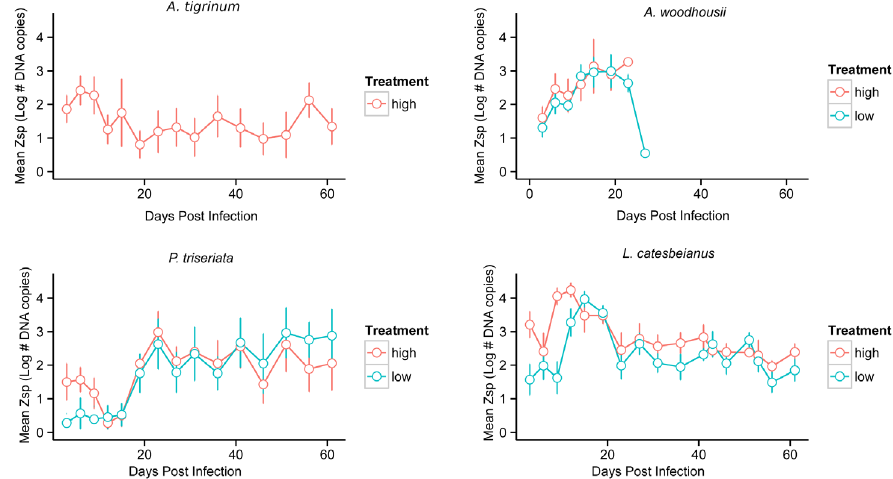
Figure 3. Plots of the mean zoospore output over time for four species experimentally infected with Bd. Mean zoospore output (with standard error bars) of individuals within each treatment group (high and low) over the 62-day time course of the laboratory experiment. Zoospore output over time calculated by taking Simpson’s numeric integral to find area under curve of zoospore output over time for each species. Treatment group (high or low treatment) alone did not have a statistically significant relationship with the integrated zoospore output of individuals over time (p=0.62) in a linear mixed model predicting total zoospore output over time. No species x treatment group interactions were significantly related to total zoospore output for any species (p . 0.67 for all species x treatment group interactions). The species A. tigrinum and A. woodhousii had a statistically significant negative association with zoospore output in comparison to the total zoospore output from L. catesbeianus individuals (p = 0.029, 0.023,